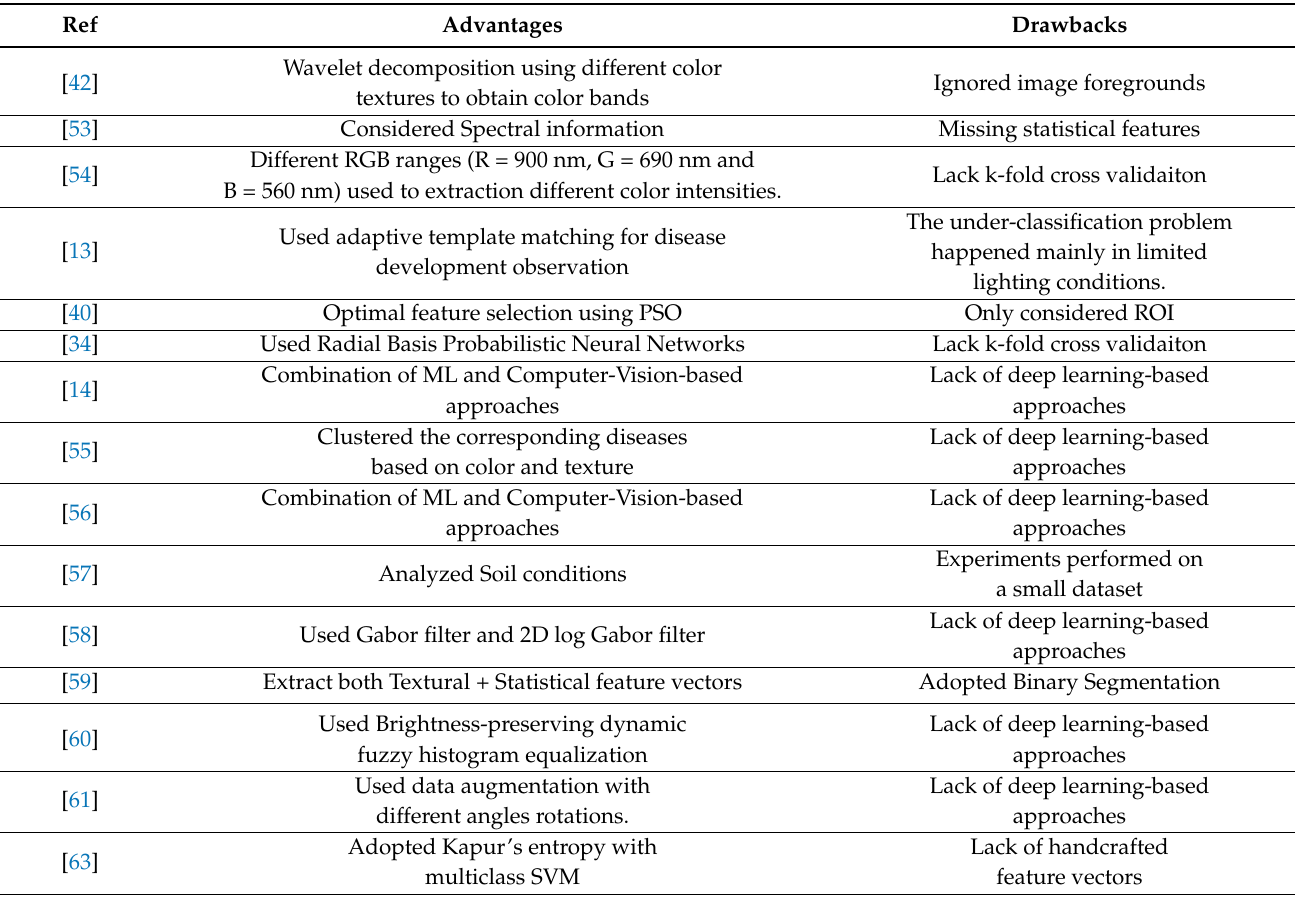
Table 2. Critics (advantages and drawbacks) of the related